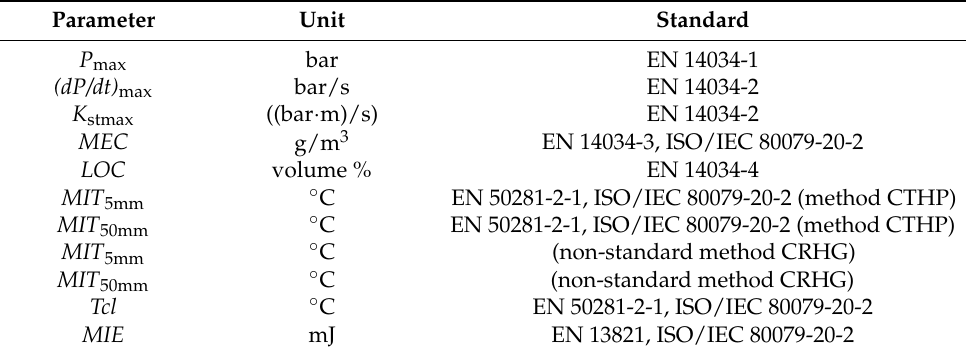
Table 2. Standards used to determine of explosion and fire properties of